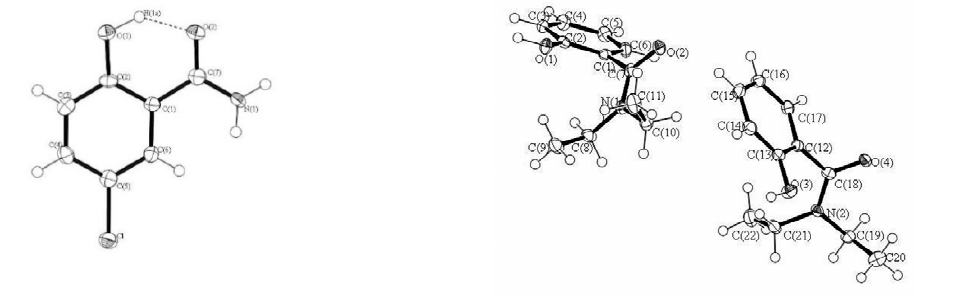
Figure 14. The single crystal structures of 5-chloro-2-hydroxy-benzamide and 2-hydroxy-N,N-diethylbenzamide.